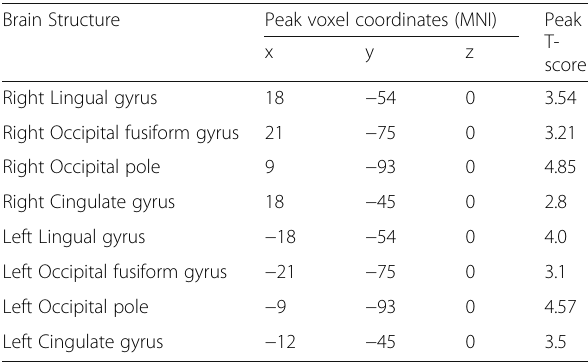
Table 5 Increased functional connectivity in MO compared with HC